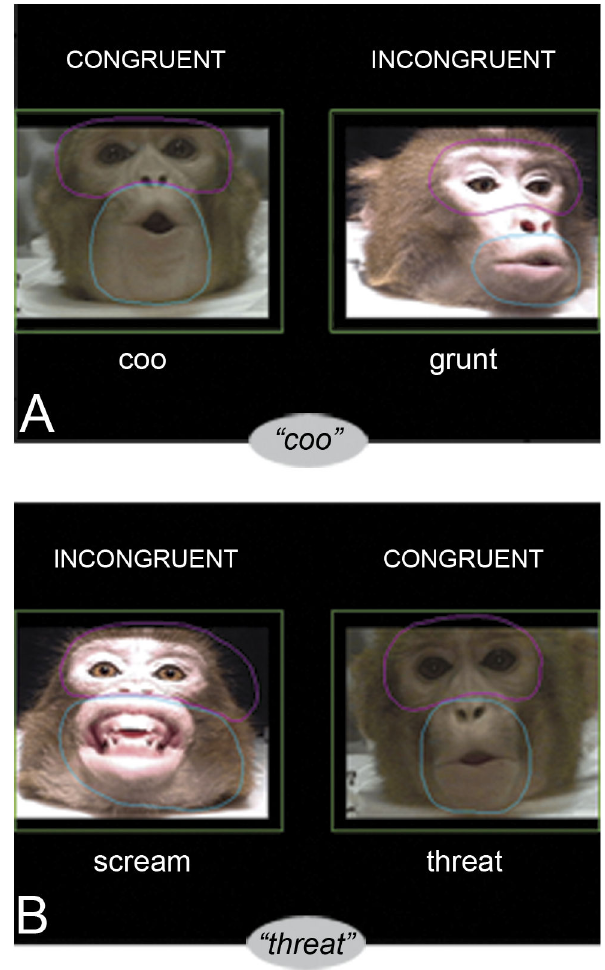
Task. The auditory component and the left-right position of the two facial gestures were counterbalanced. Stimuli were presented under two different conditions: Synchronized